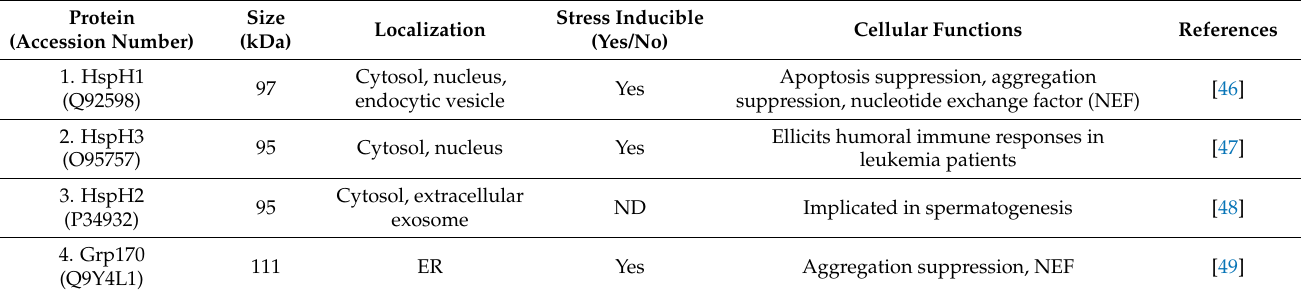
Figure 2. General structural features of human Hsp110s: ( A ) Structure of Hsp110 showing major features, including the unique acidic insertions in the substrate binding domain (SBD) α region. ( B ) Comparative structural analyses of a canonical Hsp70 (HspA1, purple) and an Hsp110 (HspH1, grey). Variations are predicted to occur within L 1,2 and L 4,5 . ( C ) The nucleotide binding domains (NBDs) of human HspH1 (cyan), HspH2 (purple), HspH3 (grey) and Grp170 (blue) show high conservation. ( D ) The SBDs of human HspH1 (cyan), HspH2 (purple), HspH3 (grey) and Grp170 (blue) show variation within the SBD β segments. ( E ) Major variations are predicted to occur at loops L4,5 and L5,6 of the SBD β segments of human HspH1 (cyan), HspH2 (purple), HspH3 (grey) and Grp170 (blue). Table 1. Hsp110/Grp170 proteins of human